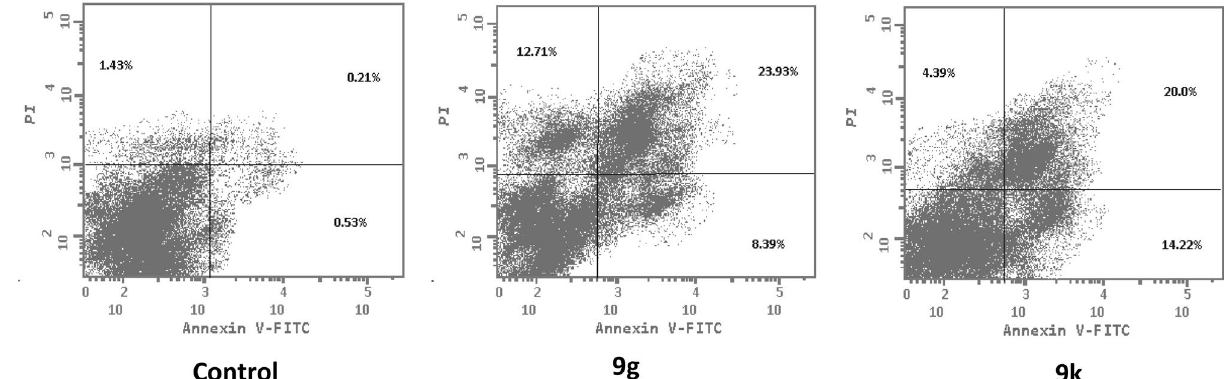
Figure 3. Effect of pyrazolines 9g and 9k on the percentage of annexin V-FITC-positive staining in MDA-MB-231 cells.